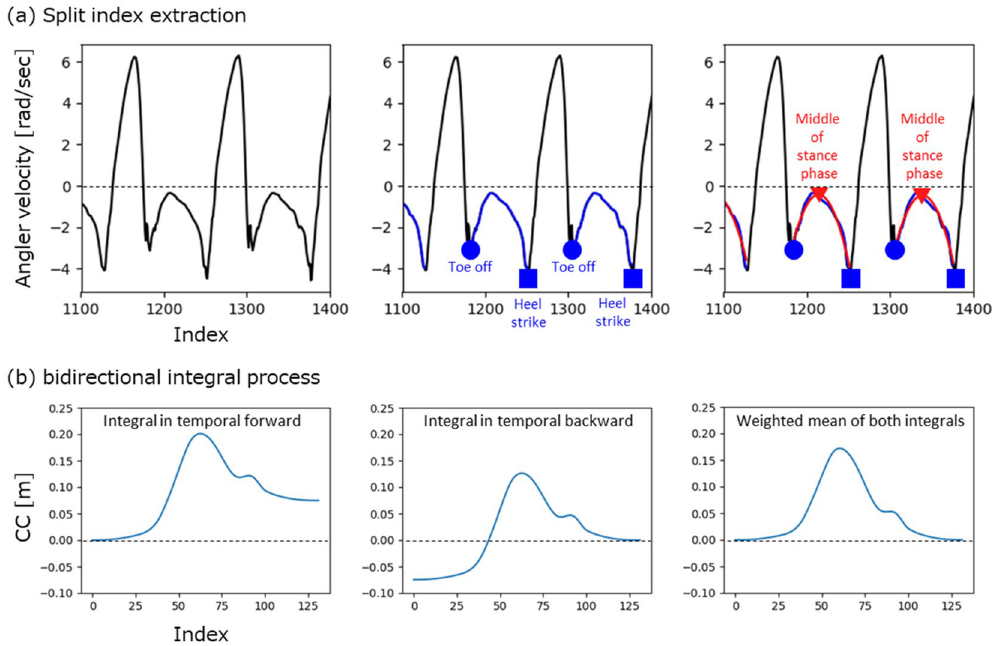
Figure 10. Process components for calculating local stepwise gait trajectory. ( a ) Example of split index extraction. Left part figure shows angular velocity of Z axis with median filter (window length: 5). Center part figure shows the timings of the toe off and the heel strike were extracted by searching the local maximum. Right part figure shows the parabolic regression model was applied to the angular velocity of stance phase which is between the toe off and the heel strike. ( b ) Example of bidirectional integral process with cranio-caudal component of trajectory. Left part figure is output trajectory from the integral calculation of velocity in the direction of temporal forward. Center part figure is output trajectory from the integral calculation of velocity in the direction of temporal backward. Right part figure is output of weighted mean of both outputs in the direction of temporal forward and temporal